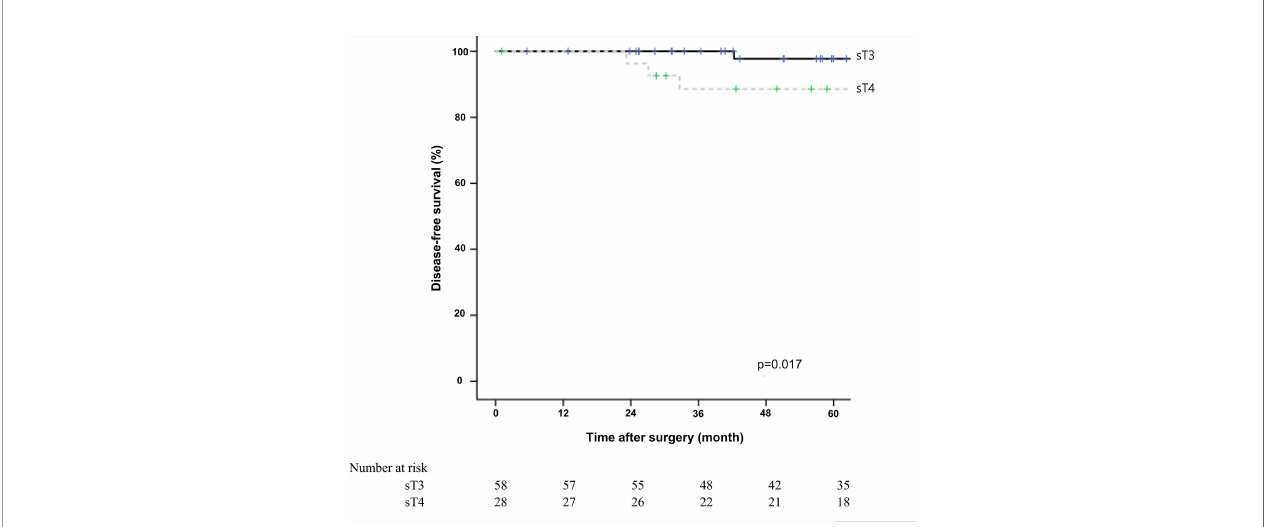
FIGURE 2 | Comparing disease-free survival for right colon adenocarcinoma between surgical stage T4 (sT4) and surgical stage T3 (sT3) in patients with pT3N0M0 by Kaplan-Meier curve. The 5-year disease-free survival rate of sT4 group was signi fi cantly lower than that of sT3 groups according to log-rank test (88.6% vs. 97.7%, p =0.017).